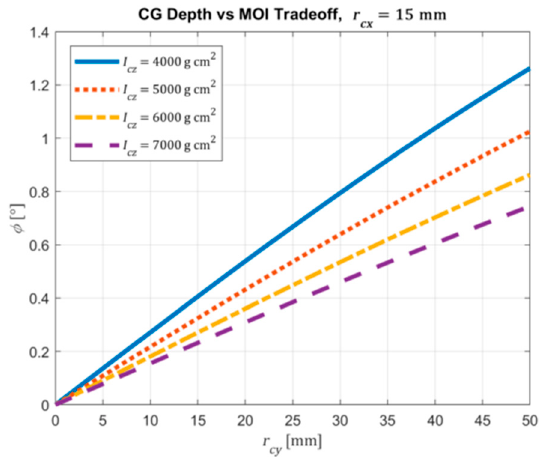
Figure 2. Launch direction as a function of CG depth for a 15 mm toe